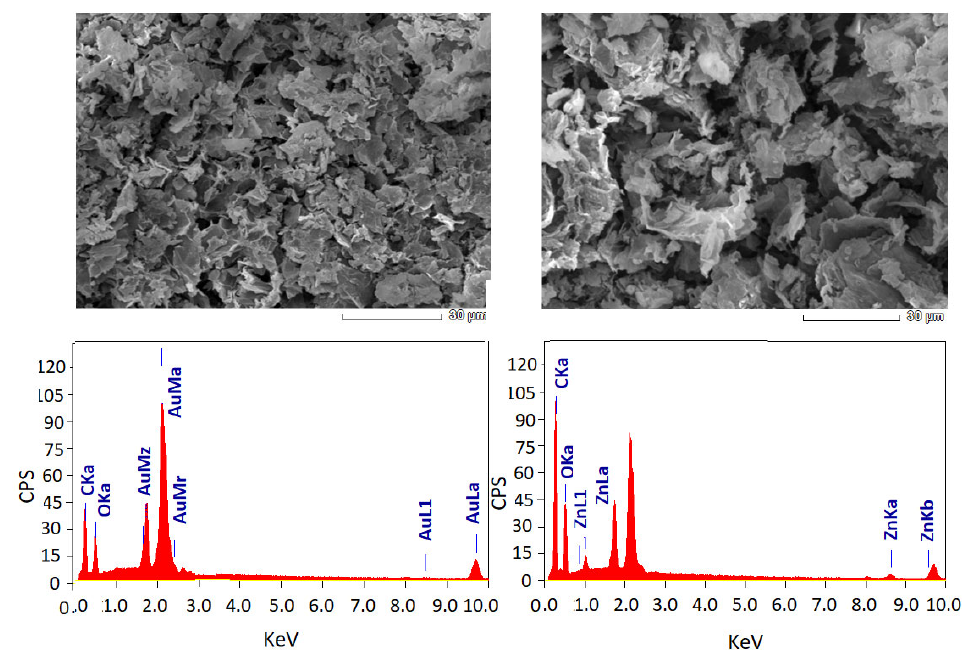
Figure 6. SEM images with EDX for ( Left ) pristine GO, in comparison with ( Right ) Zn3 /GO.